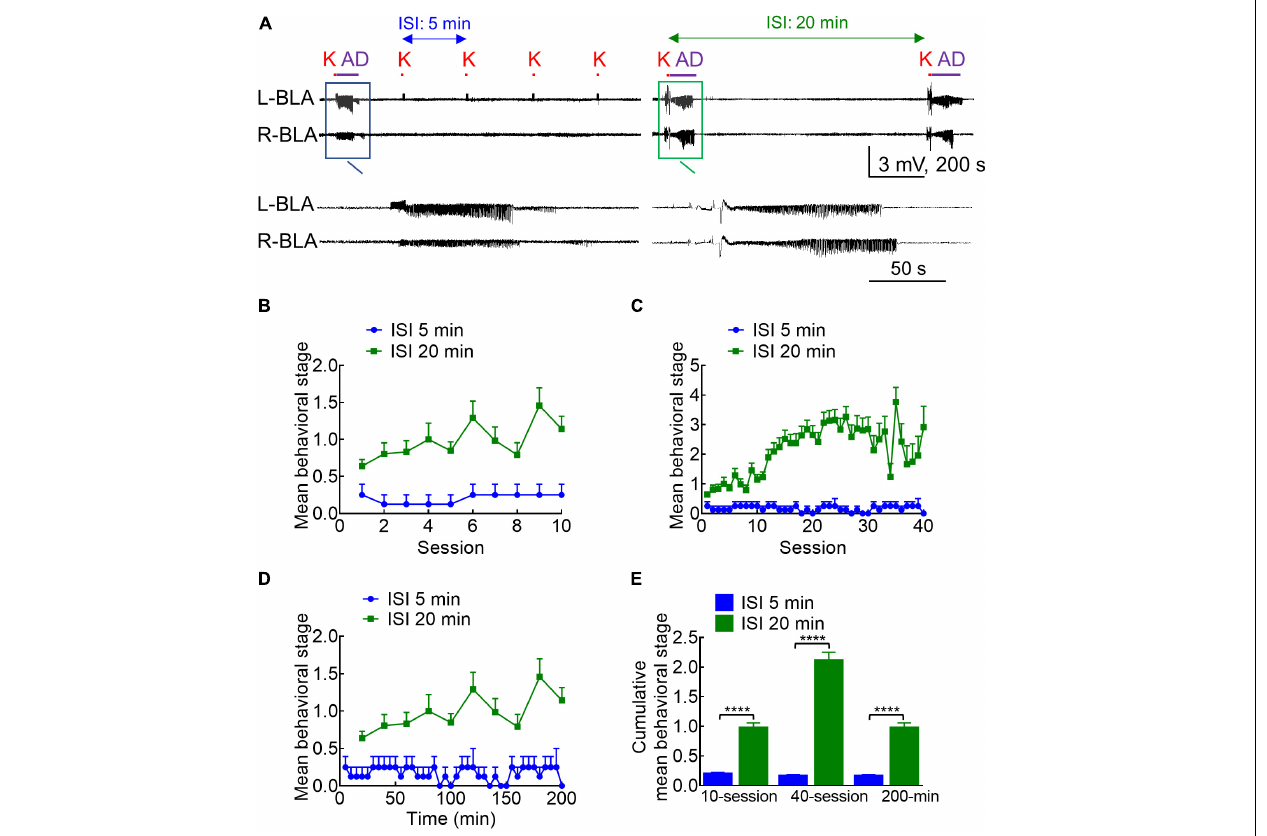
FIGURE 2 | Different kindling effects with different intervals between the 10 s stimulation intersession interval (ISI). (A) Samples of LFP were recorded in the BLA with an ISI of 5 min (left panel) or 20 min (right panel). K denotes the 10 s kindling stimulus. Only one episode of AD was induced with 5 min ISI, but nearly every stimulus with 20 min ISI induces AD (a close look is provided in the boxed panels). (B) Comparison of the mean behavioral stages for 10 sessions of stimulation between the 5 and 20 min ISI groups shows that the stage is always higher with the latter than with the former. (C) The mean behavioral stage for 40 sessions of 20 min ISI (10 sessions/day, completed in 4 days) than the 40 sessions of 5 min ISI (completed in 1 day). (D) The mean behavioral stage in a total elapsed time of 200 mins is higher with 20 min ISI (10 stimulation sessions) than 5 min ISI (40 stimulation sessions). (E) The cumulative mean behavioral stage is always higher with 20 min ISI than with 5 min ISI, no matter the mean stage is based on 10 sessions ( n = 10, 10 from the mean of 4 rats for 5 min ISI and the mean of 36 rats for 20 min ISI, respectively), 40 sessions ( n = 40, 40 from the mean of 4 rats for 5 min ISI and the mean of 36 rats for 20 min ISI, respectively), or 200 min elapsed time ( n = 40, 10 from the mean of 4 rats for 5 min ISI and the mean of 36 rats for 20 min ISI, respectively). **** p < 0.0001, Mann–Whitney U test.